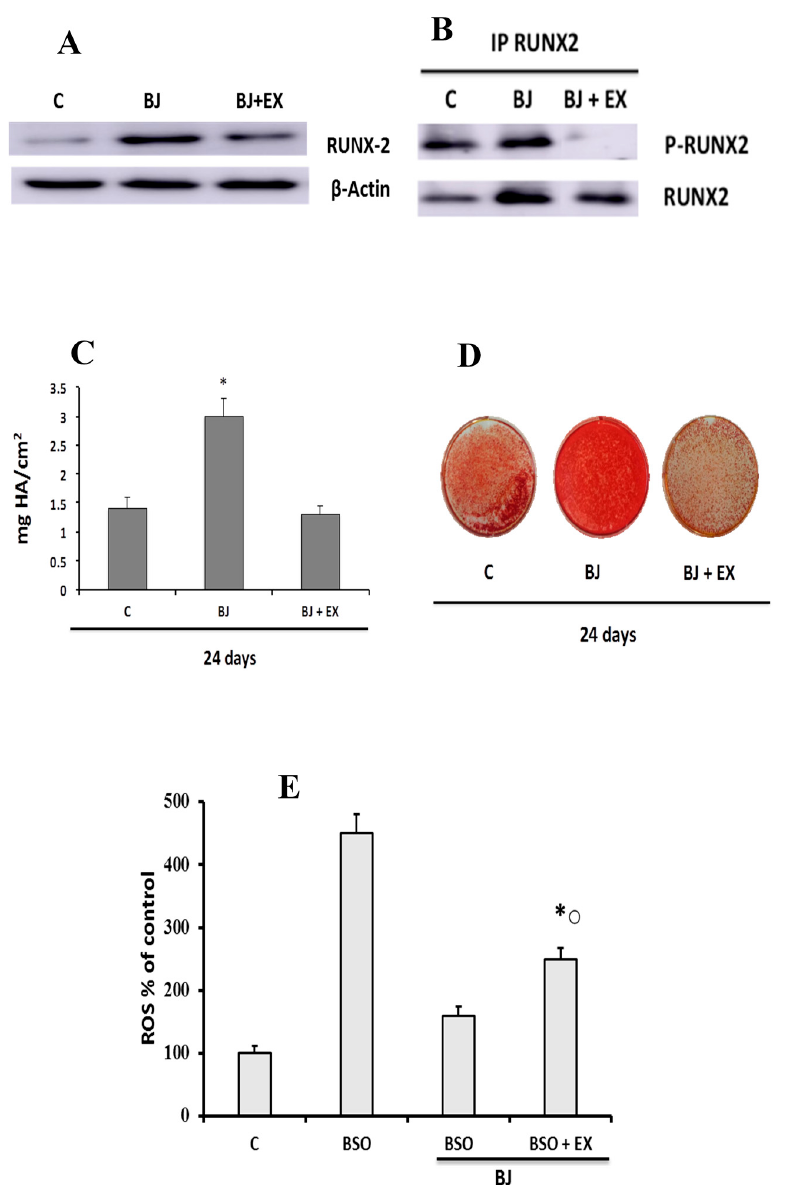
Figure 6. Effect of SIRT1 inhibition on BJ activation of RUNX-2 and the mineralization process, as well as on BJ antioxidant action during differentiation of SaOS-2 cells. RUNX-2 expression ( A ), RUNX-2 activation ( B ), calcium content ( C , D ), and ROS levels ( E ) were detected in SaOS-2 cells treated or not with BJ at 15 μ g ∙ mL − 1 total soluble polyphenols (TSP) or BSO, BSO + BJ, BJ + EX527, or BJ + BSO + EX527, for one day in growth medium (GM) and, subsequently, in osteogenic medium (OM), in the presence or not of various treatments, as reported in Section 2. RUNX-2 expression was detected after six days in OM by Western blot analysis of whole cellular lysates (A), and RUNX-2 activation was detected by phosphorylation in immunoprecipitates of nuclear extracts using the anti-RUNX-2 antibody (B). RUNX-2, p-RUNX-2, and β -actin were revealed with anti-RUNX-2, anti-p-tyrosine proteins, and anti- β -actin, respectively. The blots are representative of three experiments. Calcium content was measured after 24 days in OM, and it is expressed as mg hydroxyapatite per cm 2 (C). Representative images of calcium content in 12-well plates (D). ROS data are expressed as a percentage of the C values (E). The values are means ± SEM of three independent experiments; * p ≤ 0.05 compared to the respective C cells; ○ p ≤ 0.05 compared to BSO + BJ-treated cells.